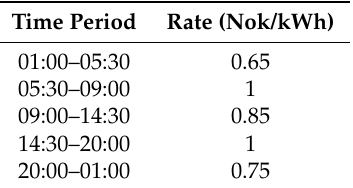
Table 4. Energy consumption rates.